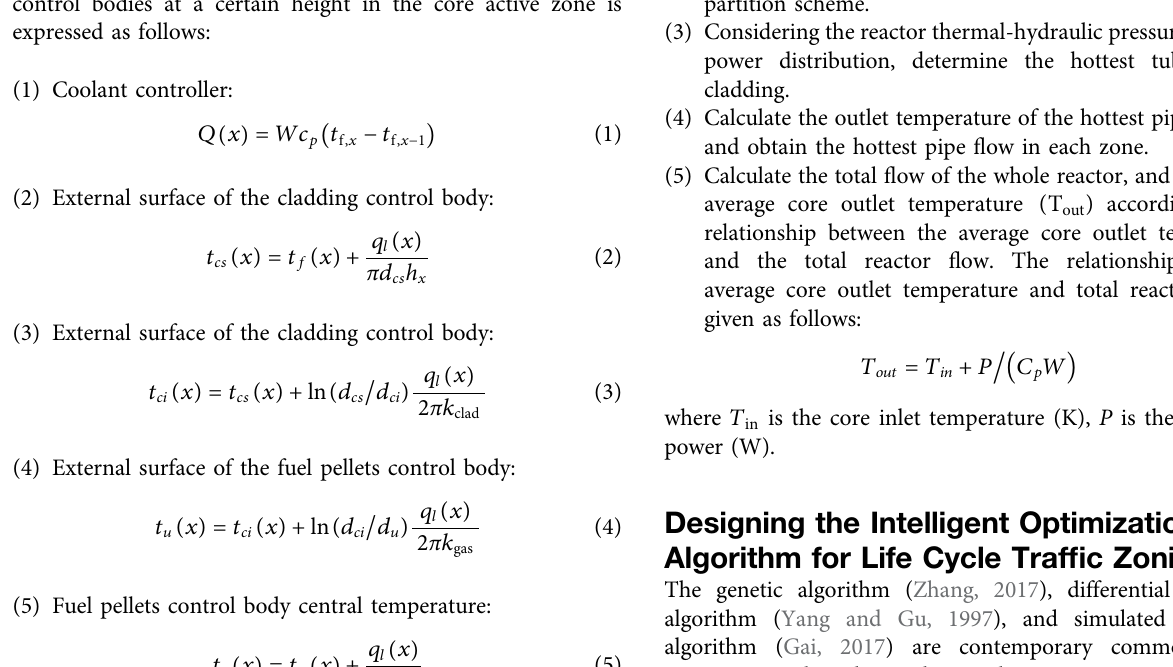
The genetic algorithm (Zhang, 2017), differential evolution algorithm (Yang and Gu, 1997), and simulated